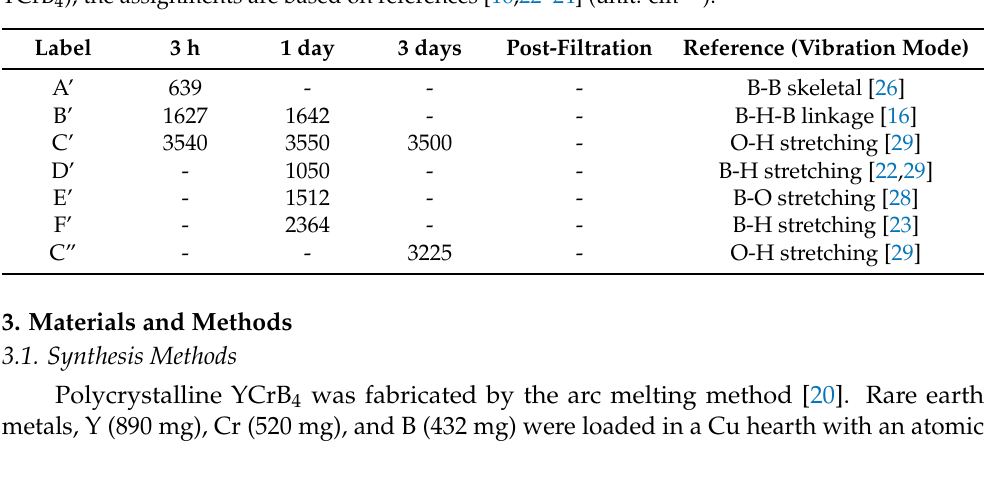
Figure 11. Difference spectrum of FT-IRAS, obtained by subtracting the spectrum of the normal ion-exchange sample from the spectrum of the acid-ion exchange sample, synthesized from bulk YCrB 4 . The measurements were taken at ( a ) 3 h, ( b ) 1 day, ( c ) 3 days, and ( d ) post-filtration. Peaks of the vibrational modes are labeled. Table 2. Summary of the assignments for the FT-IR peaks (Figure 11, sample synthesized from bulk YCrB 4 ); the assignments are based on references [16,22–24] (unit: cm − 1